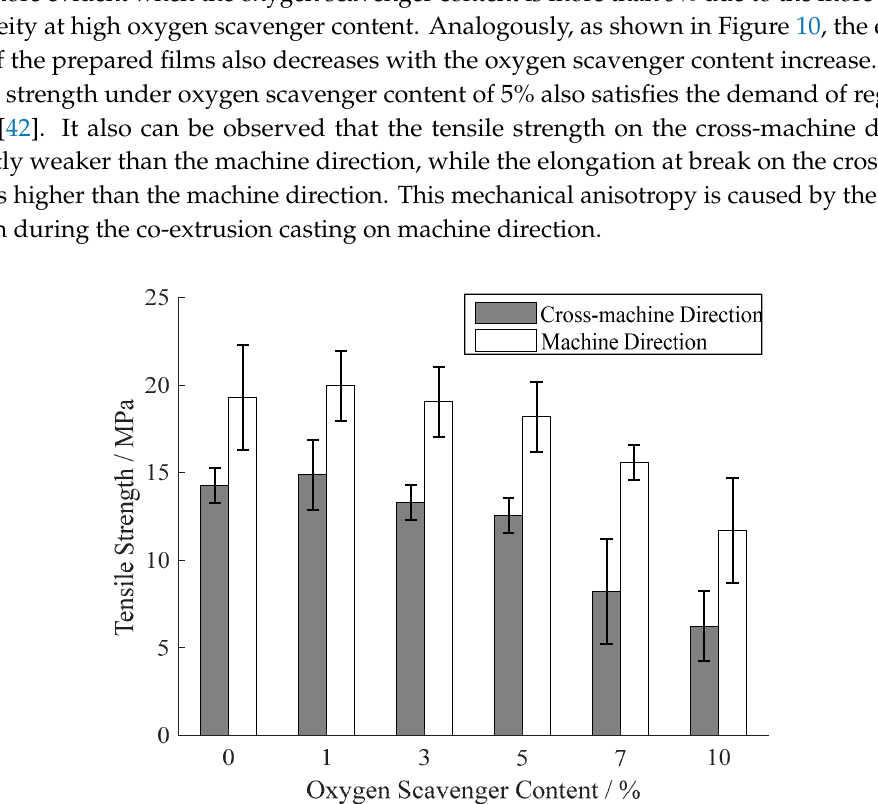
Figure 10. Elongation at break of the prepared films under different oxygen scavenger content.